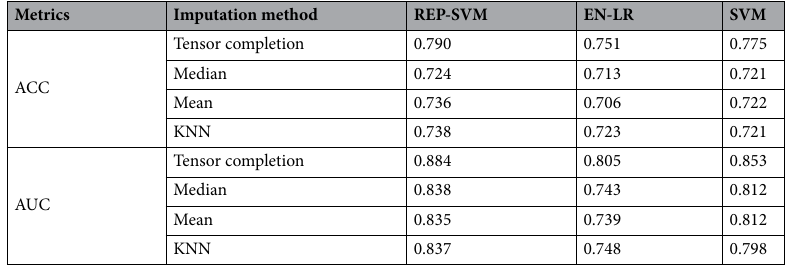
Table 3. ACC & AUC versus percentage of different imputation methods using Dataset1, where the training set contains 27 patients with seven time points and testing set consists of the remaining 26 patients with less than seven time points. Percentage of missing values in the training set 0.23% and that in the testing set is 18.1%.